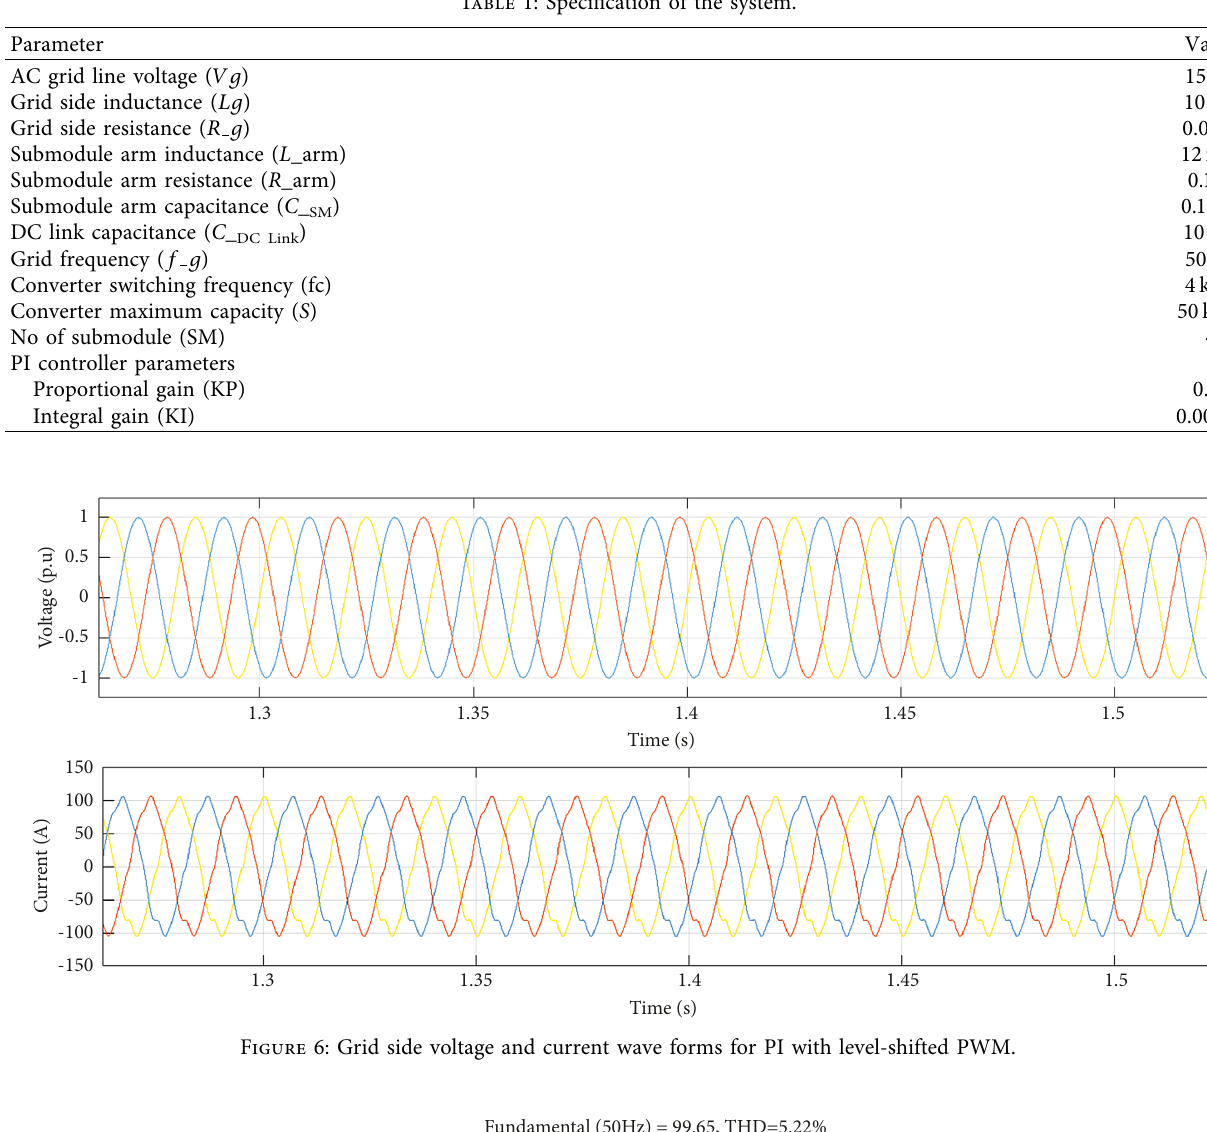
Table 1: Specification of the system.